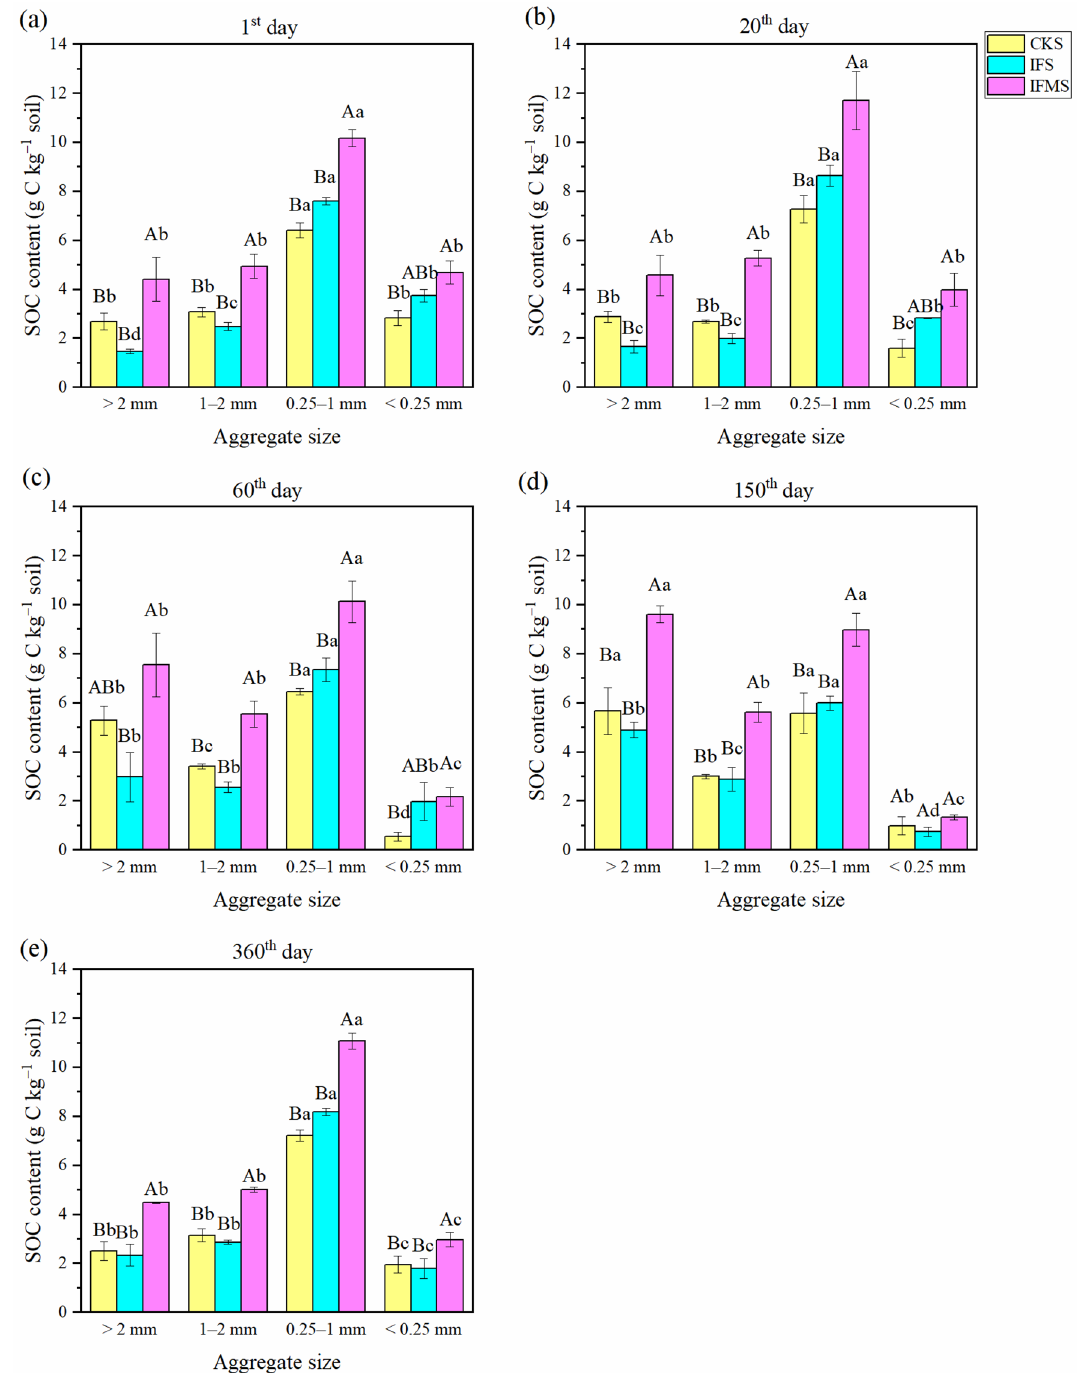
Figure 2. The SOC contents in aggregates under various fertilizer management strategies after adding straw. Note : Treatments including CKS (no fertilization control + straw), IFS (inorganic fertilizer + straw), IFMS (inorganic fertilizer plus manure + straw). Vertical bars represent the standard error of the mean significant variations (SEM; n = 3). Values followed by different letters (uppercase among various fertilizer management strategies and lowercase letters among various aggregate sizes) mean significant variations ( P < 0.05) in SOC